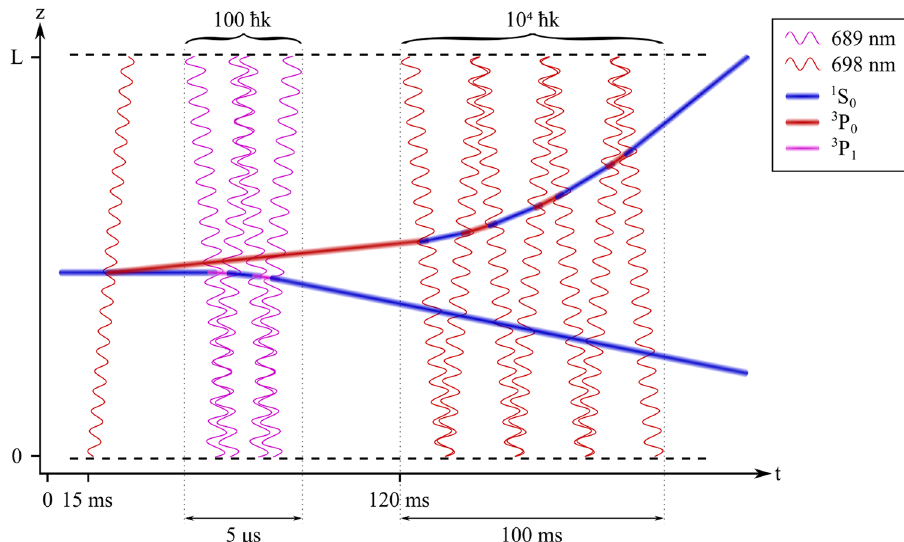
Fig. 4 Space-time diagram for large momentum transfer atom interferometry. An initial 698 nm (red, wavy) π /2-pulse transfers the atoms into a superposition between the ground state, slow-arm (blue), and the excited state, fast-arm (red). Sequential counterpropagating π -pulses on the 689 nm transition (pink, wavy) deliver 100 ℏ k of momentum to the slow-arm only. With the frequency degeneracy lifted, the main large momentum transfer sequence begins at 120 ms, delivering 10 4 ℏ k of momentum to the fast-arm through counterpropagating π -pulses on the 698 nm transition.